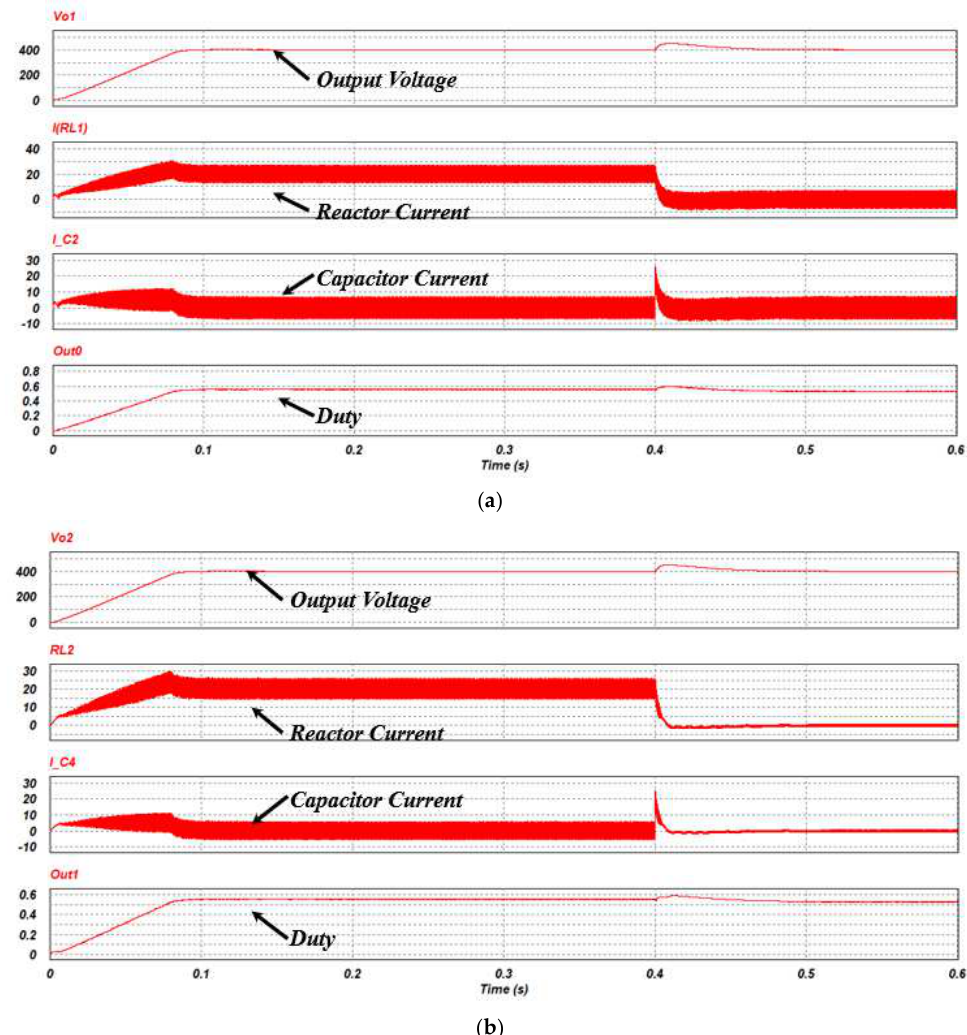
Figure 8. Simulation results. ( a ): Simulation results of conventional converters. ( b ): Simulation results of the proposed converter.